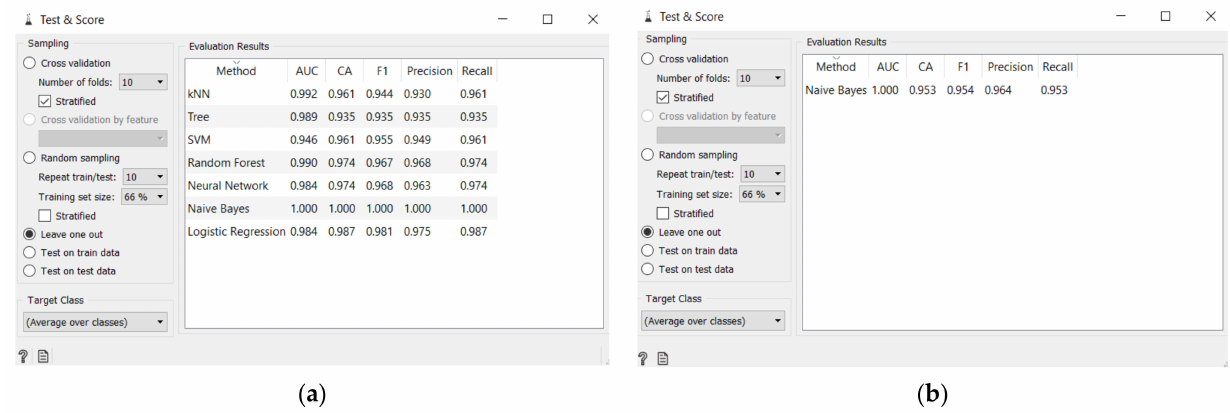
Figure 15. Test and score results: ( a ) Test and score results for each method, Naïve Bayes shows 1; ( b ) Misclassified data caused that the CA of the Naïve Bayes model is now not 1.